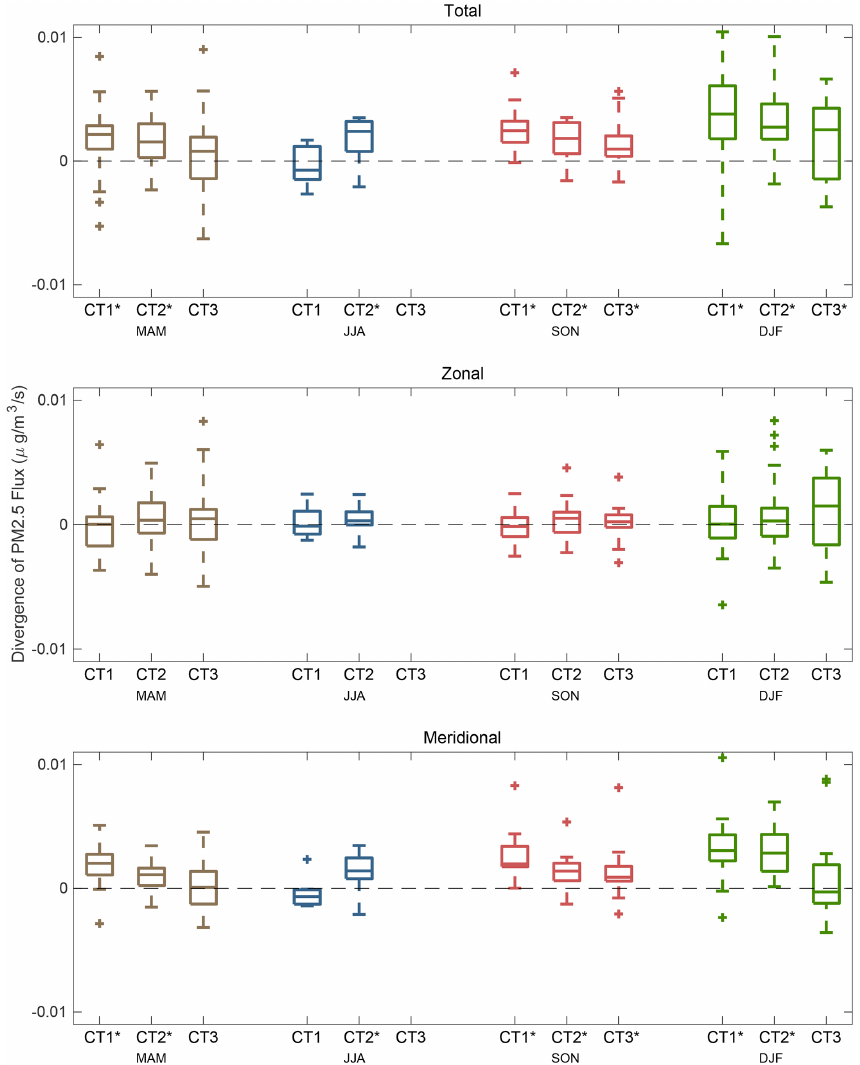
Figure 8. Boxplot of the divergence of PM 2 . 5 flux over the region of 34–40 ◦ N and 112–118 ◦ E. The daily divergence is calculated based on the Eq. (1). Zonal and meridional components are the first and second terms of the formula. An asterisk ( ∗ ) on the x axis marks the divergence in a specific CT being significantly different with zero based on a two-tailed Student’s t test at a significance level of